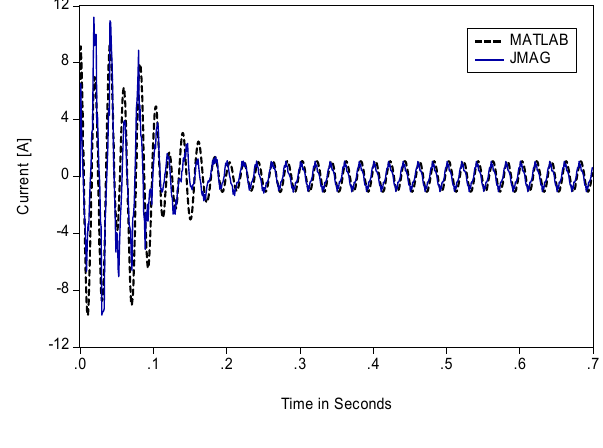
Figure 7. Stator Current at 1.5 N ∙ m load.